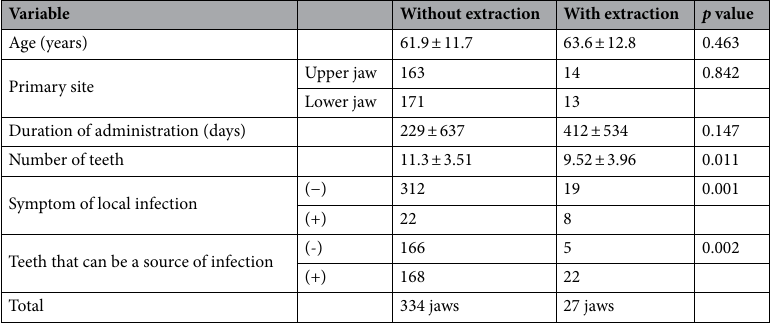
Table 3. Background factors of patients with and without tooth extraction.